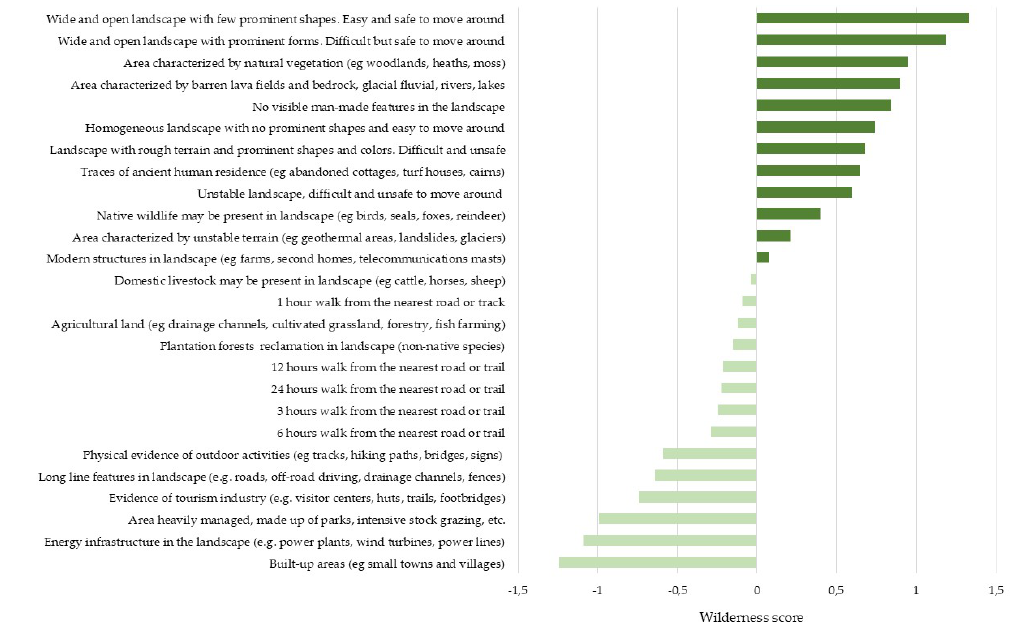
Figure 10. Attributes with positive (dark green) and negative (light green) wilderness scores. The higher the score, the stronger is the perceived wilderness perception. Likewise, the lower the score, the poorer is the perceived wilderness perception. Table 1. Statements used to describe di ff erent landscape scenarios classified according to areas’ naturalness, anthropogenic features in nature, fauna, landscape and features, and distances, and calculated wilderness